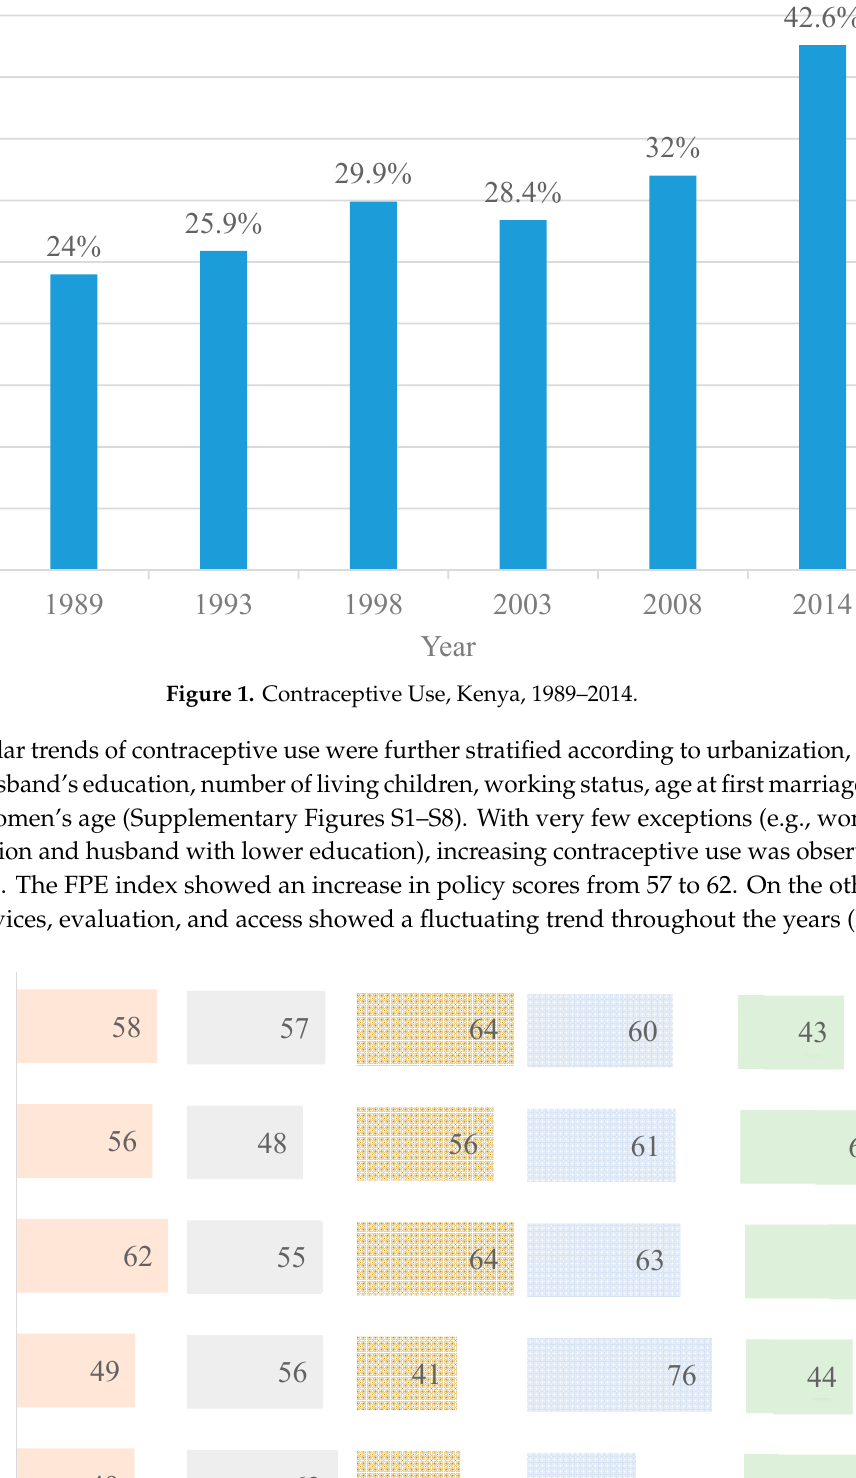
Figure 2. Trend in Family Planning Effort Index scores (FPE), 1989–2014.